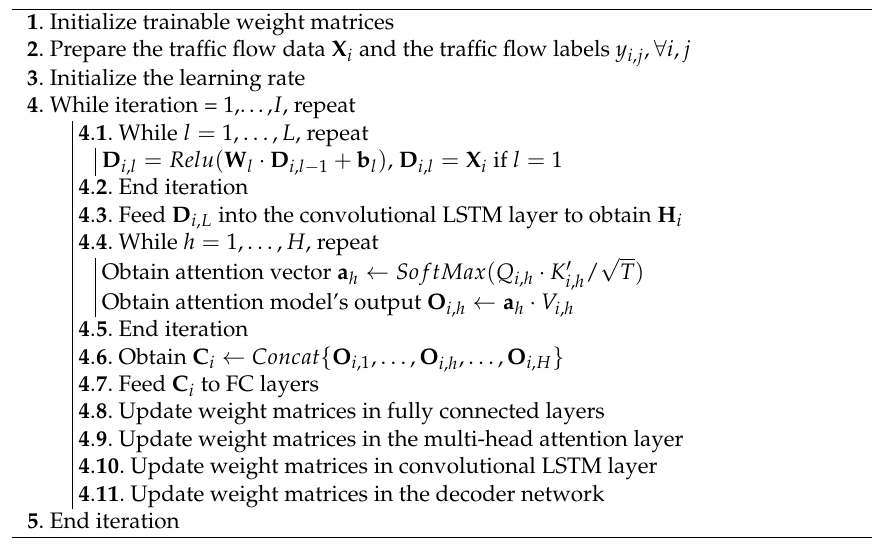
Table 1. The pseudo-code to train the proposed deep learning model for traffic flow